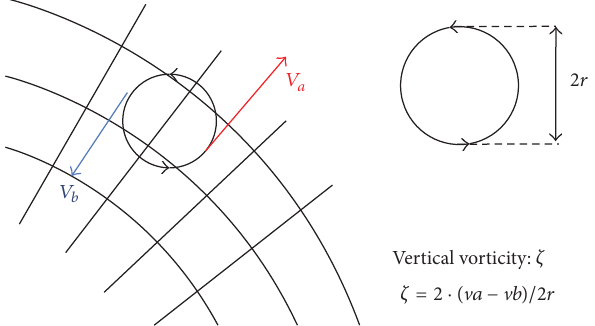
Figure 11: Formulas for vorticity calculation, which utilizes adjacent meshes of Doppler velocity data (Nakakita et al.,